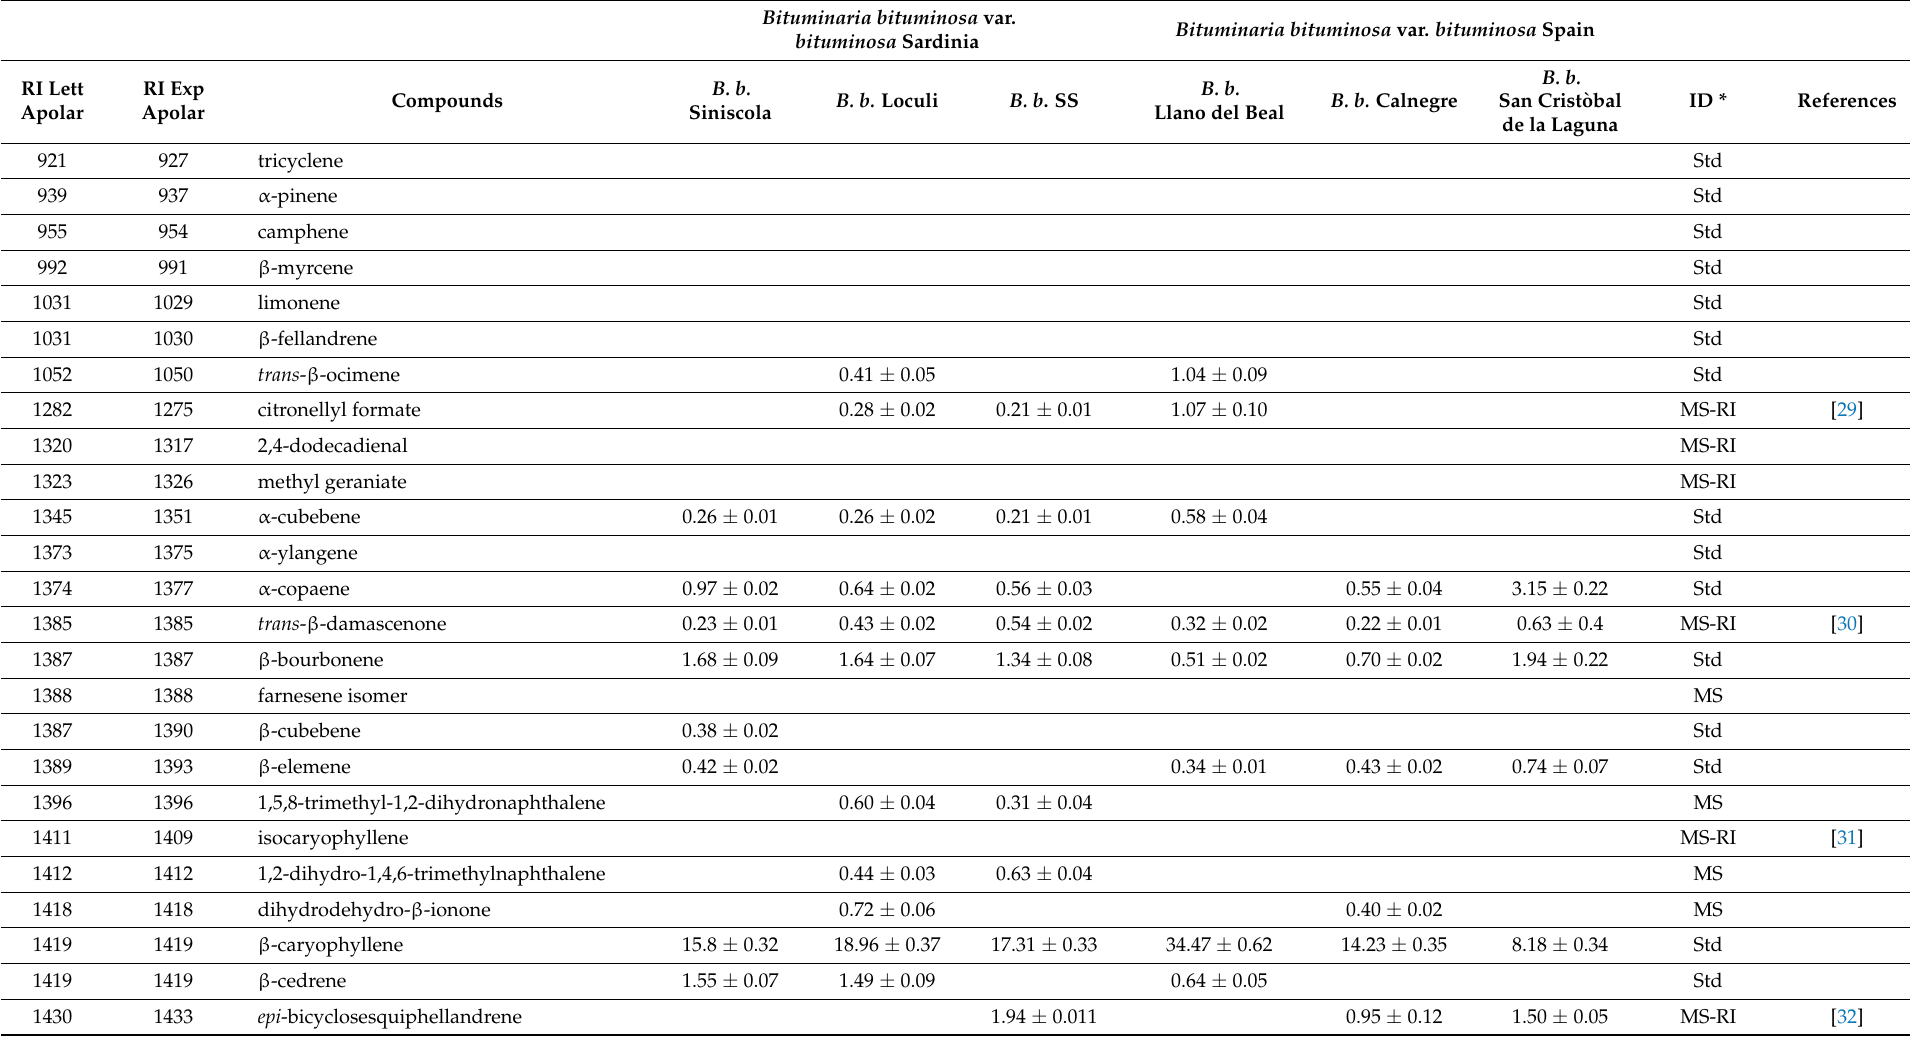
Table 1. Chemical composition of Bituminaria bituminosa (L.) C.H. Stirt. essential oils from Sardinia and Spain genotypes grown in a Sardinian experimental